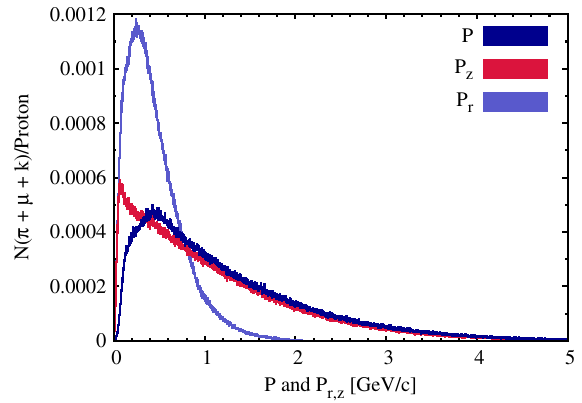
FIG. 4. Distribution in kinetic momentum of the sum of the charged pions, charged kaons, and muons, divided by the number of incident protons, at the end of the target. Distribution functions are plotted in total momentum (darker blue), longitudinal momen- tum (red), and transverse momentum (lighter blue). Transverse momentum is the magnitude of the projection of the momentum vector into the plane perpendicular to the solenoid